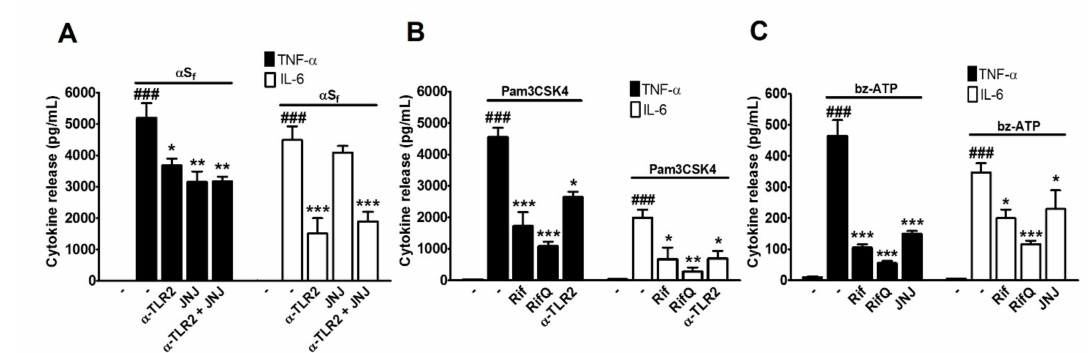
Figure 4. Inhibitory e ff ects of Rif and RifQ on microglial cells activated by either α S f or agonists of putative receptors for α S f . ( A ) Modulation of the e ff ects of α S f by α -TLR2 (2.5 µ g / ml), an antagonistic antibody against TLR2 and by JNJ 47965567 (JNJ) (20 µ M), a synthetic antagonist of P2X7 receptors. ( B ) Modulation of the e ff ects of Pam3CSK (1 µ g / ml) on TNF- α and IL-6 release in microglial cell